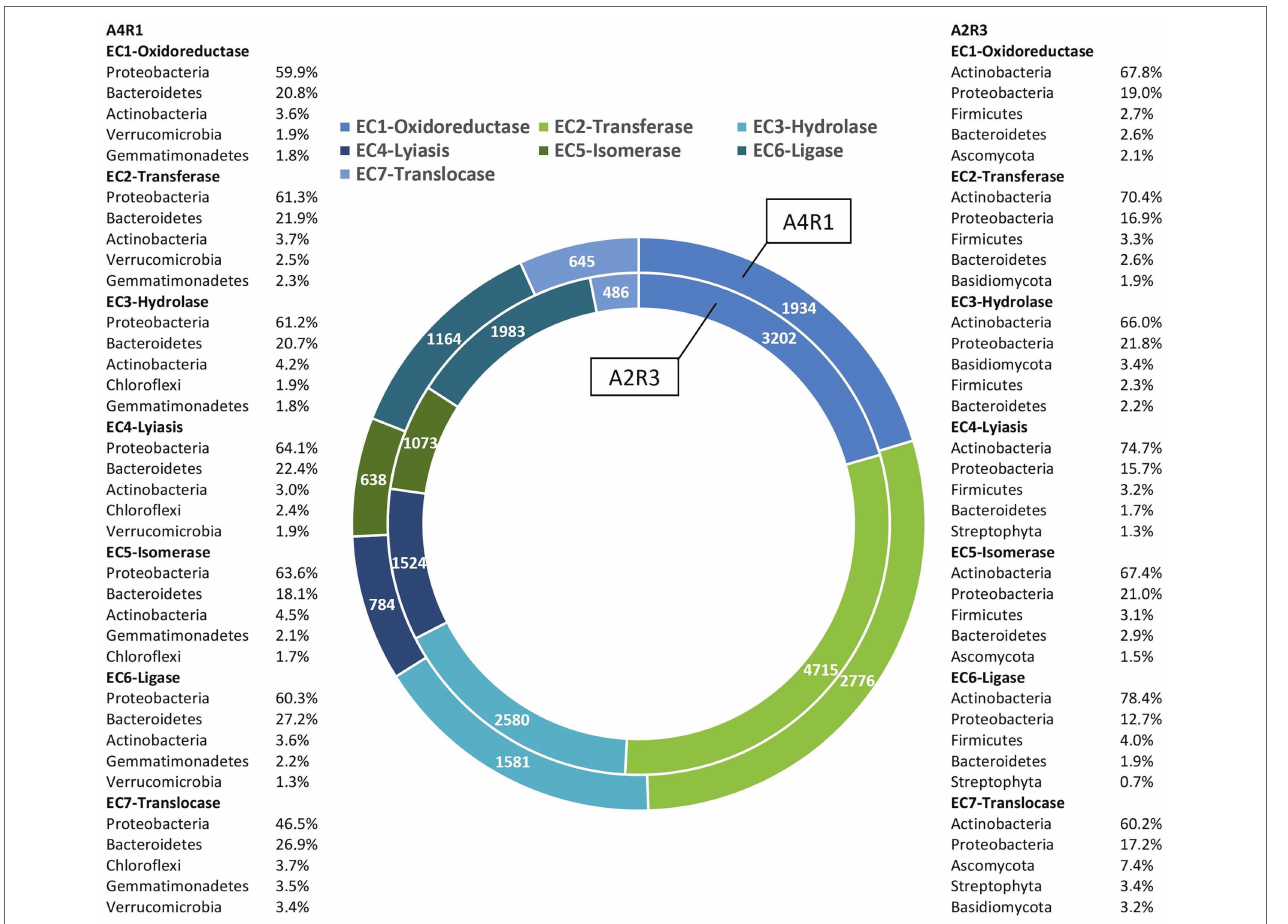
FIGURE 4 | Enzymes up-regulated in A4R1 (tot 9,522) and A2R3 (15,567) subdivided according to their enzyme class (EC1—oxidoreductase, EC2—transferase, EC3—hydrolase, EC4—lyiasis, EC5—isomerase, EC6—ligase, EC7—translocase). For each class, the % of the main Phyla expressing the enzymes are